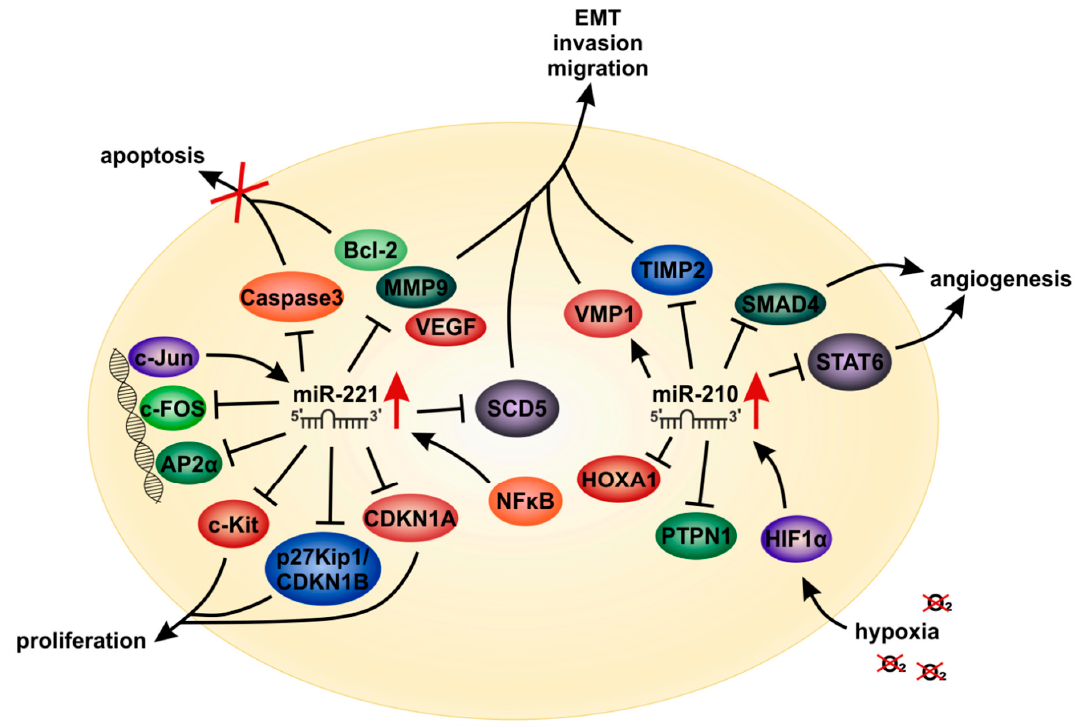
Figure 7. OncomiRs miR-221 and miR-210 and their impact on cancer cells. The miRNAs miR-221 and miR-210 are significantly upregulated during tumor development of melanoma and HCC (indicated by red arrows) which leads to interference with important cellular pathways. MiR-221 downregulates the transcription factors c-FOS [196] and AP2 α [191] and is regulated itself by c-Jun and the NF κ B pathway [213]. NF κ B regulation also leads to suppression of the miR-221 downstream genes Bcl-2, VEGF and MMP-9 thus inhibiting apoptosis [196]. MiR-221-associated anti-apoptotic activity is further mediated by targeting caspase-3 [209]. Regulation of Bcl-2, VEGF and MMP-9 by miR-221 can also induce an invasive phenotype which is further mediated by miR-221 suppressing SCD5 and thereby promoting EMT [193]. Additional miR-221 targets are c-Kit, p27Kip1/CDKN1B and CDKN1A